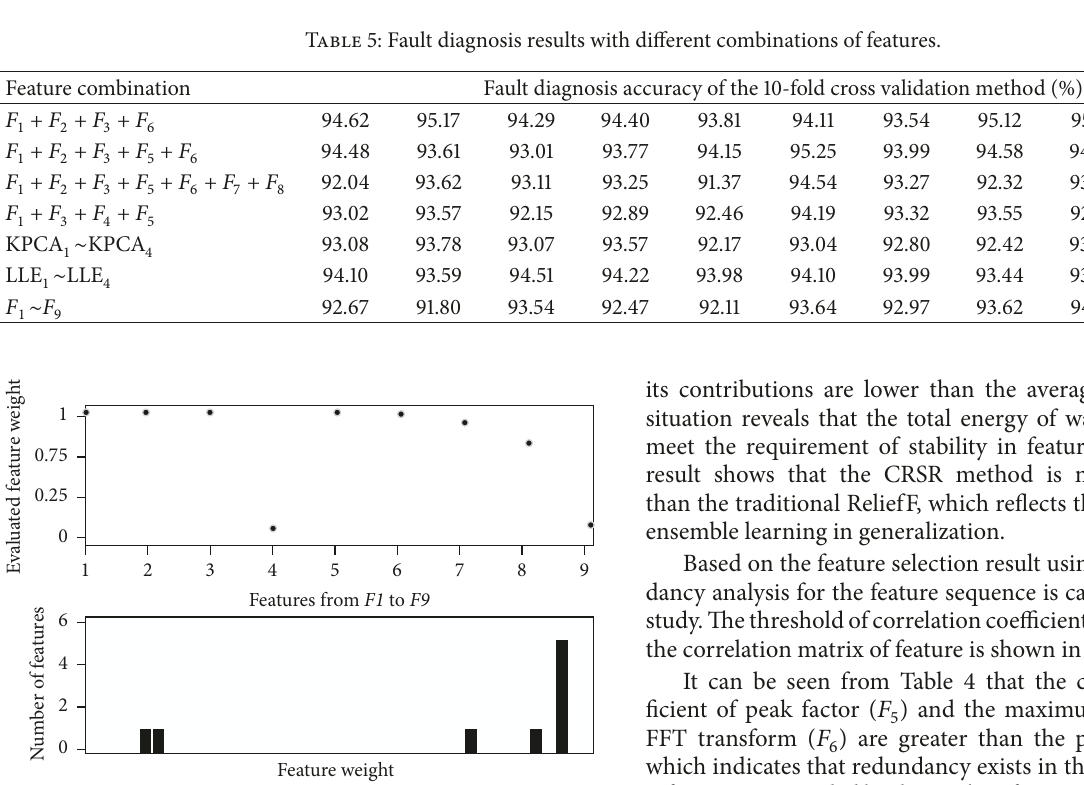
Figure 6: Statistical results based on compressed stochastic sub-